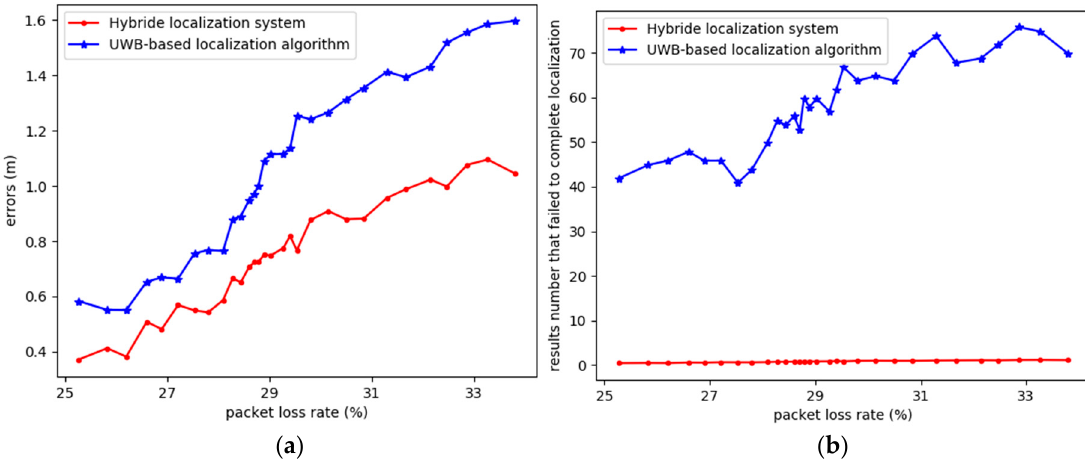
Figure 9. Comparison with different packet losses: ( a ) Average errors comparison vs. packet loss rate;